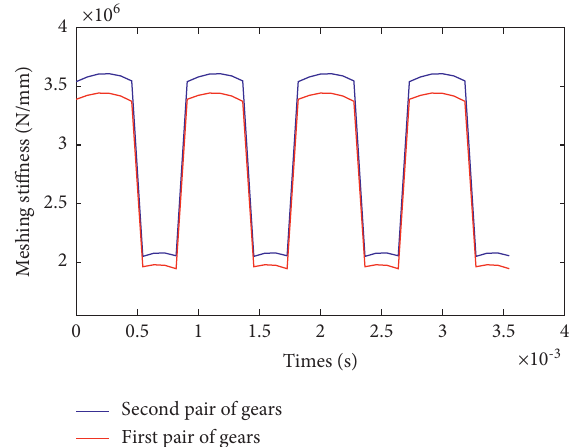
Figure 20: Meshing stiffness of two meshing gear pairs.